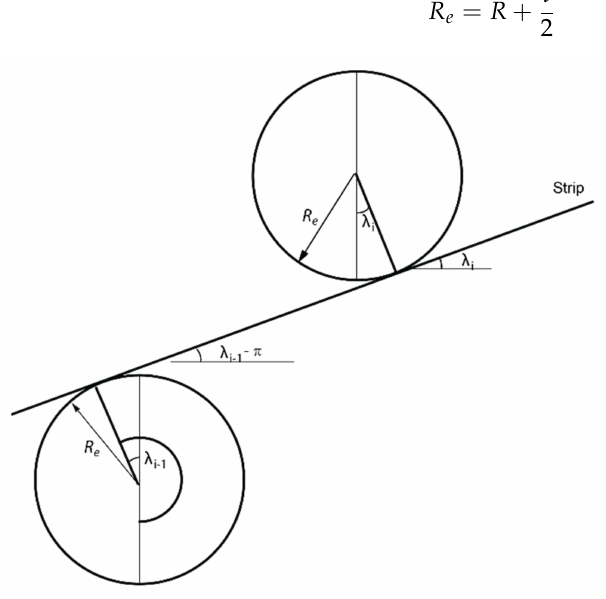
Figure 3. Tangential contact condition of the strip with the